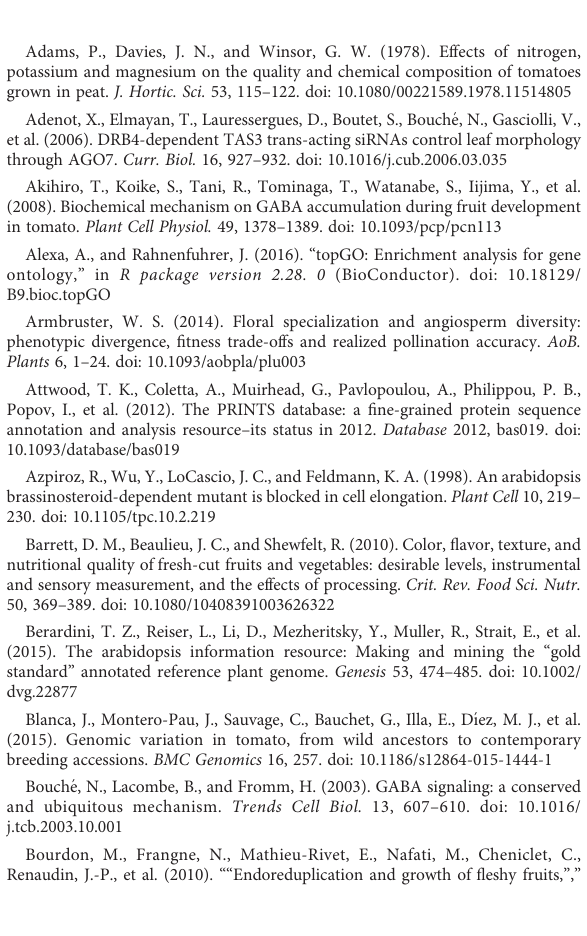
SUPPLEMENTARY FILE 2 List of gene names for divergent orthologous